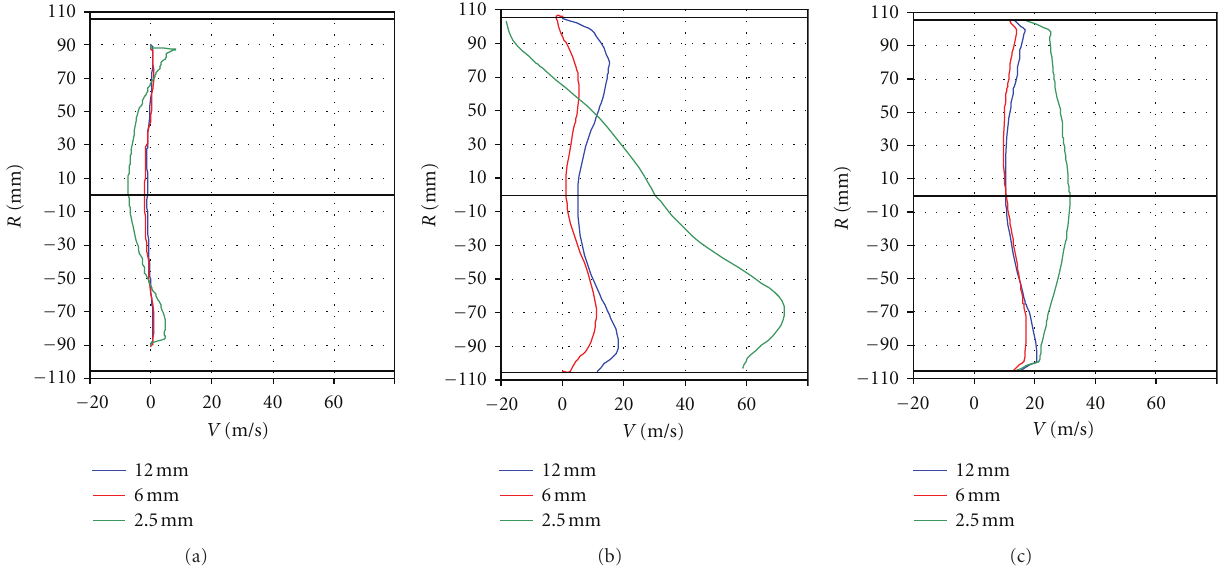
Figure 6: The velocity V distribution in the cross-sections ( X = 2 mm, 500mm, and 1000 mm).